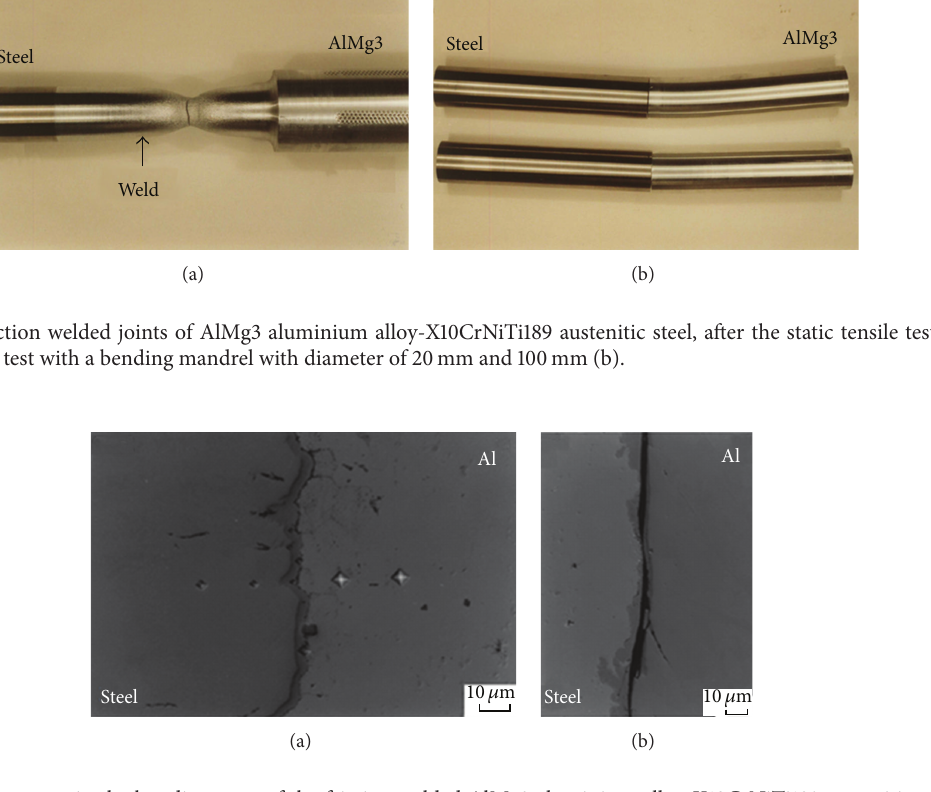
Figure 7: The microstructure in the bonding zone of the friction welded AlMg3 aluminium alloy-X10CrNiTi189 austenitic steel, together with a measurement of microhardness (a) and a bending test (b).